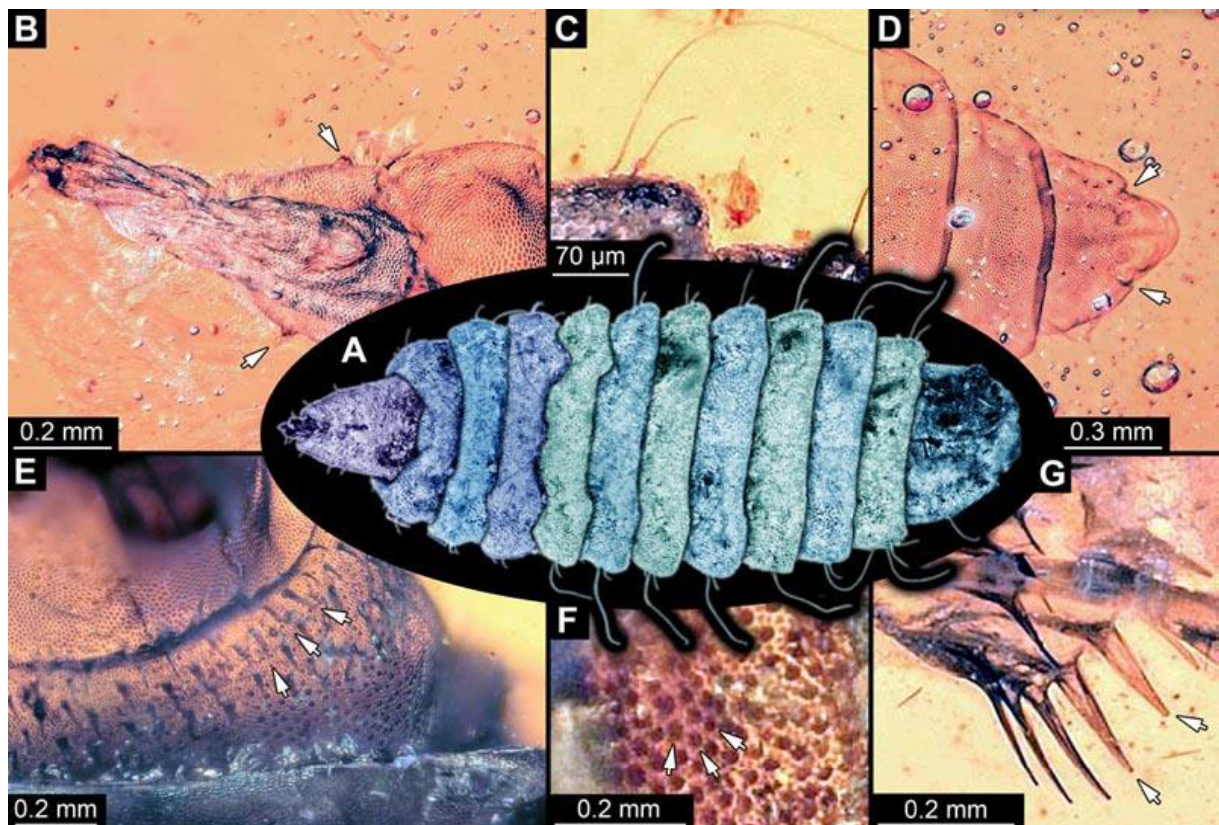
Figure 1. Overview of general structure and details of larvae of Stratiomyomorpha. ( A ). Dorsal view of specimen PED 0789. ( B ). Prothorax of specimen PED 0819-9; arrows indicate spiracles. ( C ). Hair-like setae of PED 0789. ( D ). Trunk end of specimen PED 0819-9; arrows indicate spiracles. ( E ). Spine-like setae on the mesothorax of specimen PED 1007-1 (arrows). ( F ). Surface structure (pellets or scales, arrows) of specimen PED 1254. ( G ). Ventral spine-like setae (arrows) of specimen PED 0701.